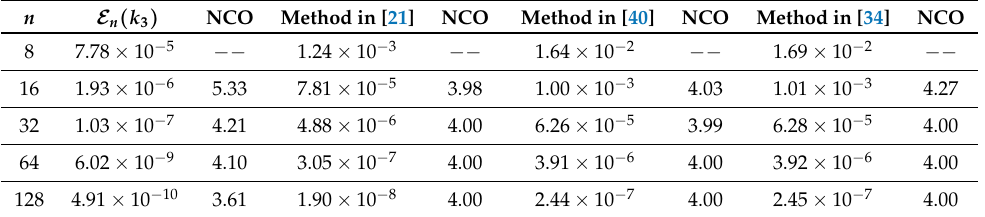
Table 6. Estimated errors for function k 3 , and NCOs with different values of n .